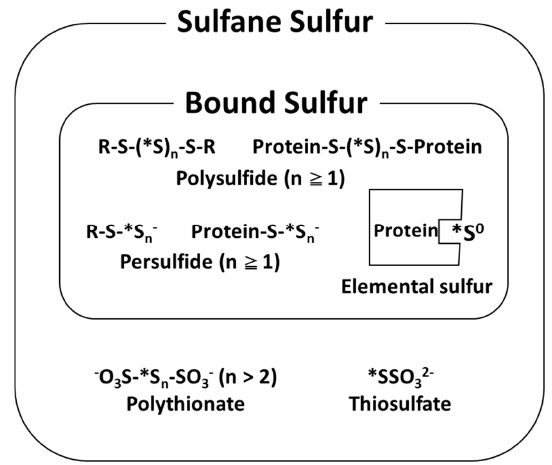
Figure 1. Definition of sulfane sulfur and bound sulfur. * sulfane sulfur.